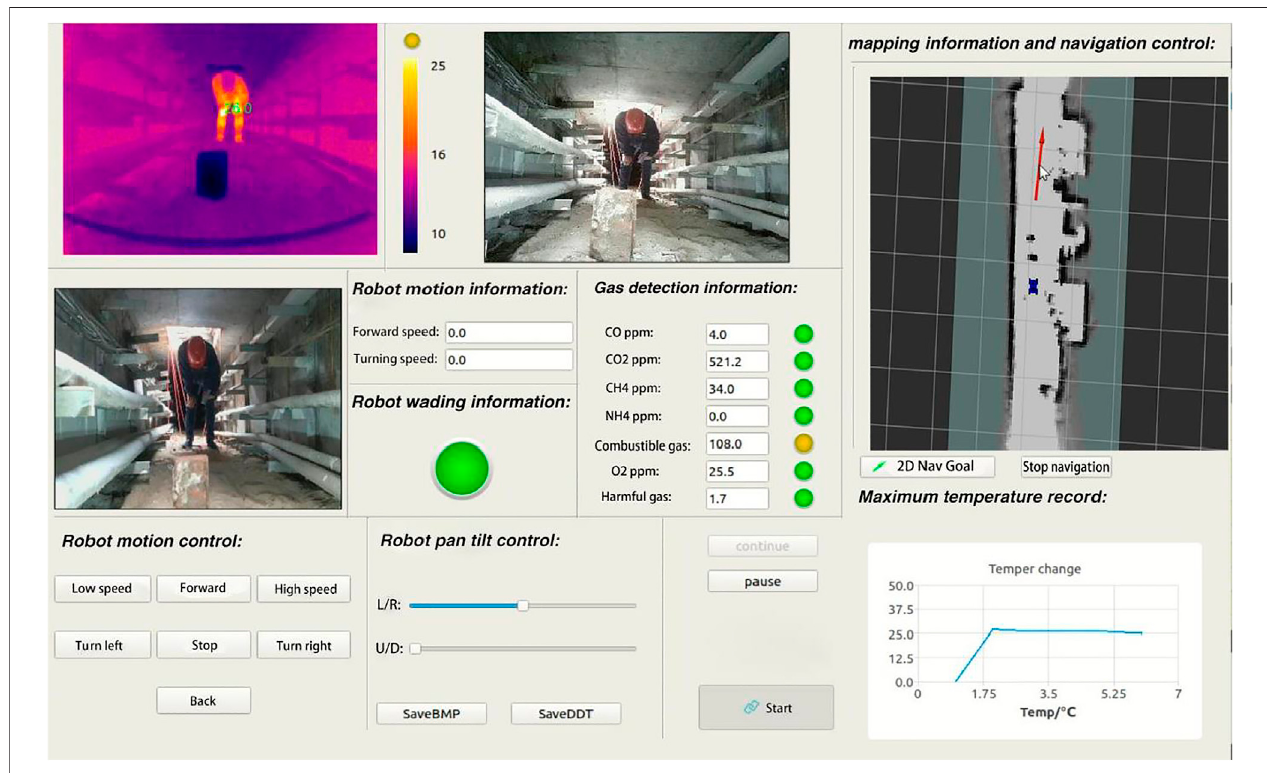
FIGURE 10 | Monitoring interface of the upper computer in the cable